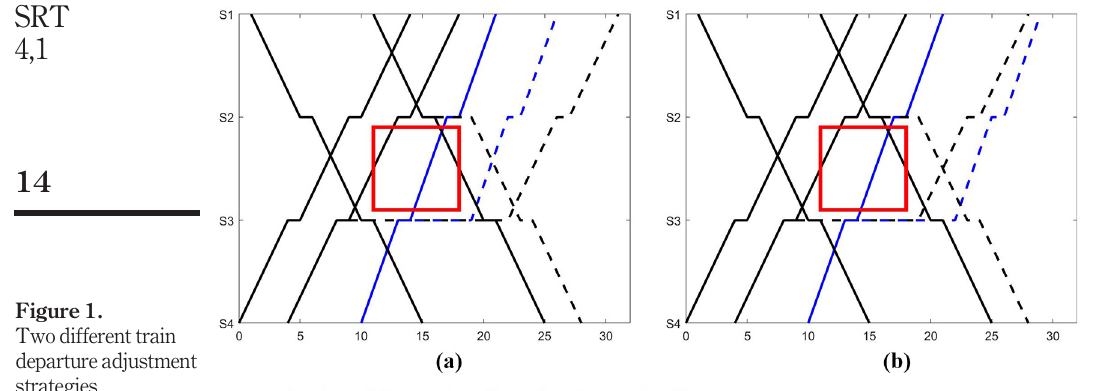
Figure 1. Two different train departure adjustment